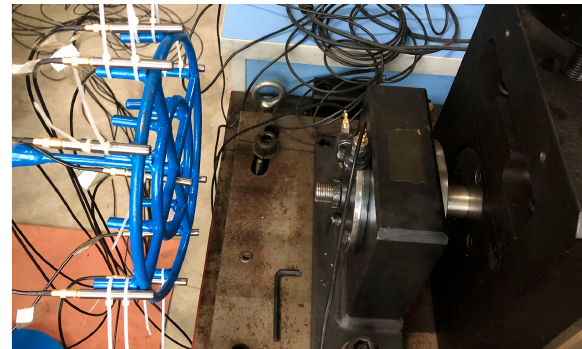
Figure 5. Experimental setup.